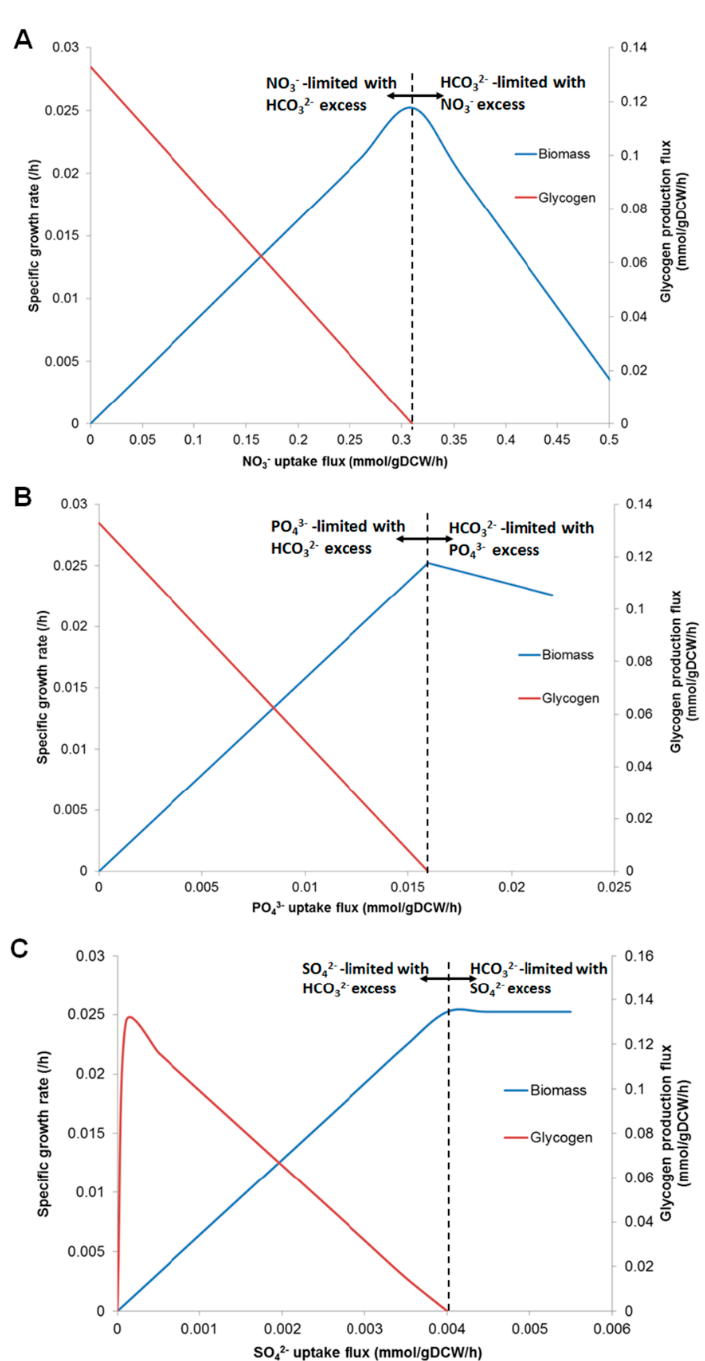
Figure 3. Prediction of nutrient effect on growth and glycogen production. The biomass and glycogen production as the functions of uptake fluxes of NO 3 − ( A ), PO 43 − ( B ), and SO 42 − ( C ). Dashed line indicates the optimal uptake rate for growth.